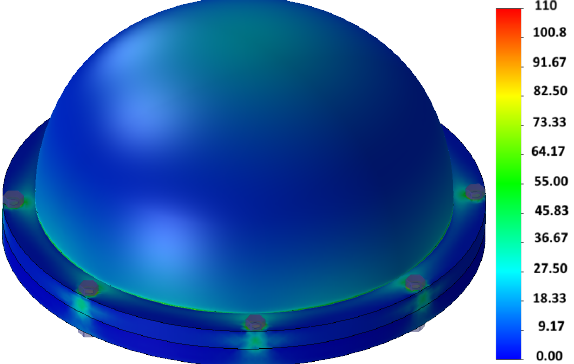
Figure 17. Dome stresses (Von Mises [MPa]) due to static pressure (1.45 MPa) for a thickness of 10